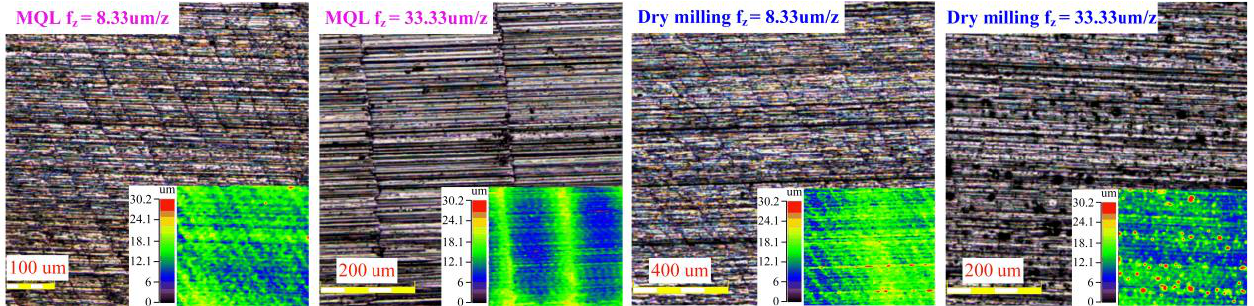
10 of 31 Figure 11. The surface topography of the machined workpiece at different axial cutting depths. Figure 12 shows the surface topography of the machined workpiece at different feeds per tooth. When the feed per tooth is 8.33 μm/z, the height distrib ution of the surface is uniform for both dry milling and MQL conditions, but there are slight banding bulges on the surface. The banding bulges under MQL condition are caused by the feeding tool